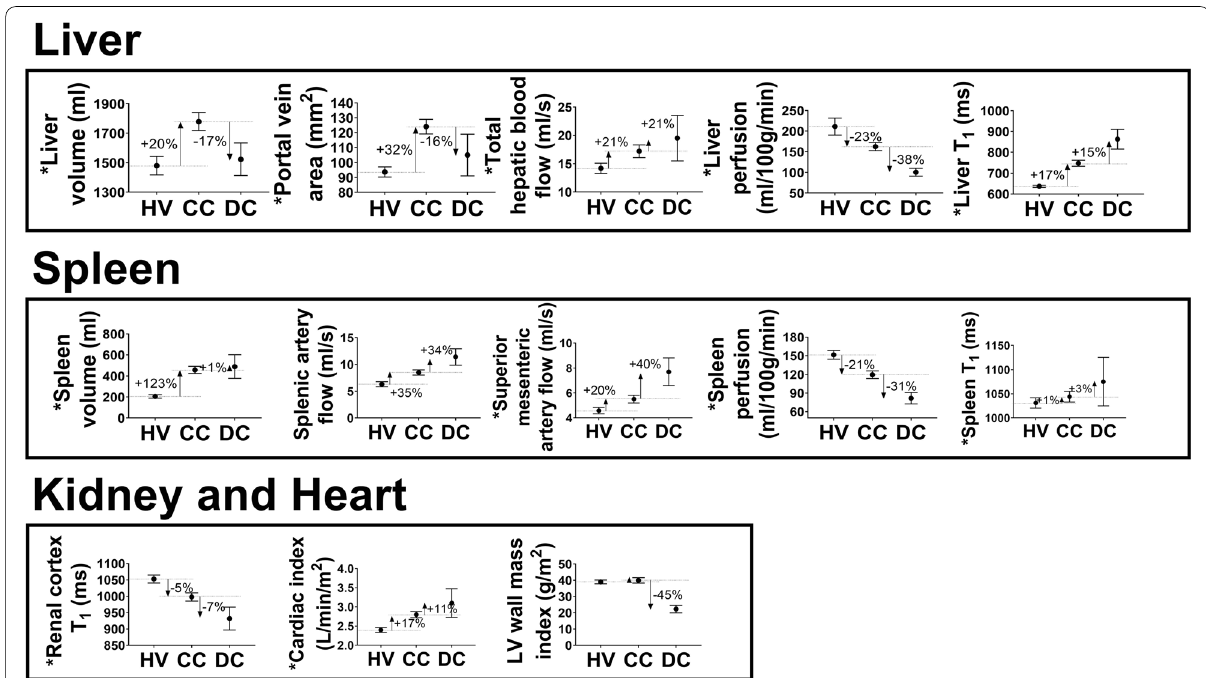
Fig. 2 Baseline magnetic resonance imaging parameters for 40 healthy volunteers (HV), 60 compensated cirrhosis (CC) patients, and 7 decompensated cirrhosis (DC) patients. Baseline measures (mean and standard error of the mean) of the liver (volume, portal vein area, total hepatic blood flow, liver perfusion, liver T1), spleen (volume, splenic artery flow and superior mesenteric artery flow, spleen perfusion, spleen T1), kidney (renal cortex T1), and heart (cardiac index and left ventricle [LV] wall mass index) are shown, with the percentage change between the HV and CC groups, and CC and DC groups shown by arrows. Asterisk indicates measures which are significantly different ( p < 0.05, independent samples t -test) between the CC and HV group